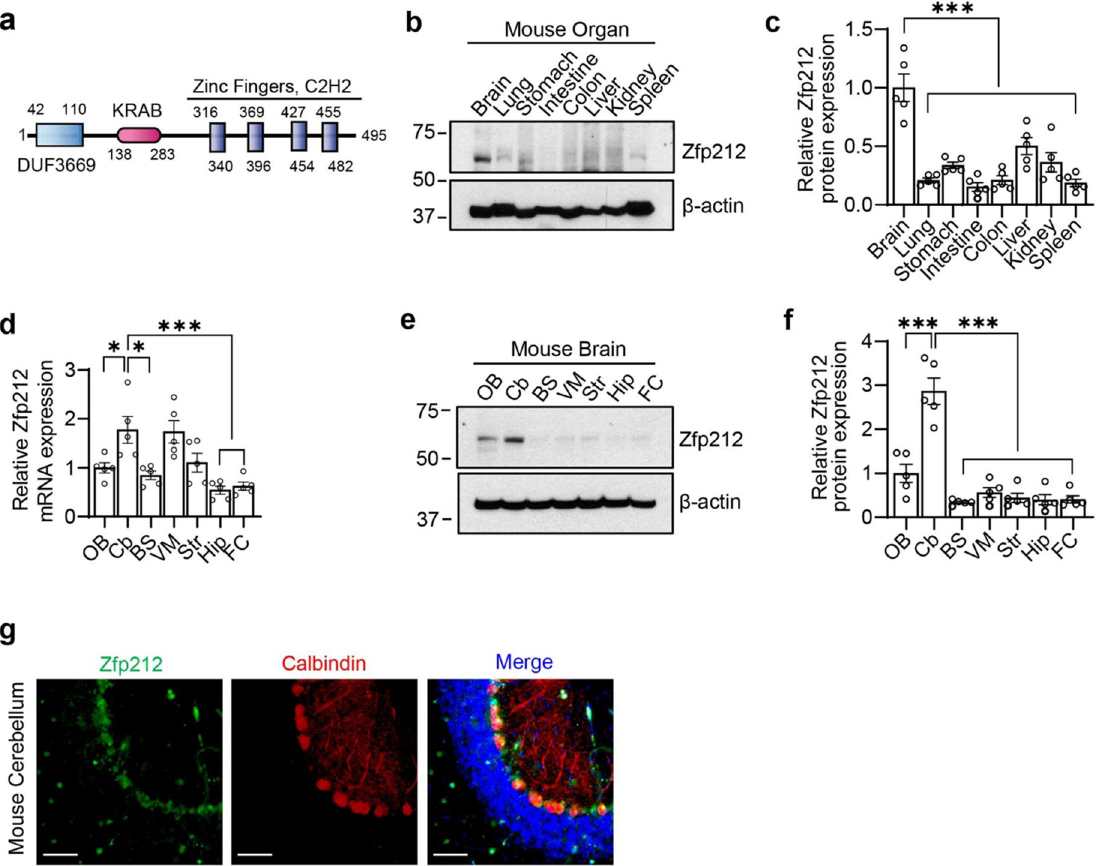
Figure 1. Zfp212 is expressed in the cerebellum. ( a ) Functional domains of human ZNF212. ZNF212 is composed of DUF3669, KRAB, and C2H2 zinc-finger domains. ( b , c ) Expression profile of Zfp212 in mouse organs. Zfp212 is highly expressed in the brain. Quantification of immunoblots ( c , n = 5). ( d ) RT-qPCR analysis of Zfp212 in the sub-regions of the brain (OB; olfactory bulb, Cb; cerebellum, BS; brain stem, VM; ventral midbrain, Str; striatum, Hip; hippocampus, and FC; frontal cortex). Relative mRNA levels were normalized to the reference gene Rpl32 ( n = 5). ( e , f ) Immunoblot of Zfp212 in sub-regions of the mouse brain. Quantification of immunoblots ( f , n = 5). ( g ) Immunofluorescence of ZNF212 and calbindin (Purkinje cell marker) in the lobule V of mouse cerebellum. Scale bars = 50 Zfp212 did not cause significant death at a young age (Fig. S3g). However, 40% of the Zfp212-KO mice died at approximately 22 months of age compared to the WT and Het mice (Fig. S3g). Since Zfp212 is abundant in calbindin-positive Purkinje cells of Cb, we monitored the levels of GAD65/67 (GABAergic neuronal marker), NeuN (neuronal marker), and GFAP (glial marker) in the Cb of Zfp212-WT and KO mice at 3, 5, and 8 weeks of age (Fig. 2a). Notably, the levels of NeuN and GFAP were comparable in all groups. In contrast, GAD65/67 was dramatically decreased in the Cb of 8-week-old Zfp212-Het and KO mice but not in that of younger Zfp212-Het and KO mice, suggesting that ZNF212 is required for the integrity of Purkinje cells at the adult stage (Fig. 2a). In addition, Nissl staining of Cb of 8-week-old Zfp212-WT and KO mice showed a significant loss of Purkinje neurons in the lobules I/II of 8-week-old Zfp212-KO cerebellum (Fig. 2b). To assess the degeneration of Purkinje cells in the absence of Zfp212, Nissl staining of Cb sections of 3-month-old Zfp212-WT and KO mice were compared, which indicated that the number of Purkinje cells was reduced in the motor-associated lobules I/II, III, IV/V, and VIII as well as nonmotor lobules VI and IX/X of Zfp212-KO mice compared to that of WT mice (Fig. S4a). Immunohistochemical staining confirmed that the number of calbindin-positive Purkinje cells declined by 30% and 50% in the Cb of 3- and 18-month-old Zfp212- KO mice, respectively (Fig. 2c). Immunofluorescence with calbindin and NeuN antibodies also showed reduced numbers and loose and shorter dendrites of Purkinje cells in the Cb of 18-month-old Zfp212-KO compared to WT, whereas NeuN-positive granular cells were comparable between Zfp212-WT and KO mice (Fig. S4b). To determine the morphological degeneration of Purkinje cells in Zfp212-KO mice, we applied Golgi staining and skeletonized images for quantification (Fig. 2d). The neuronal area of Purkinje cells in the Cb of Zfp212- WT was significantly larger than that of Zfp212-KO, whereas the soma size was comparable between groups. Dendrite Sholl analysis showed that dendrites of Zfp212-KO Purkinje cells were significantly shorter than those